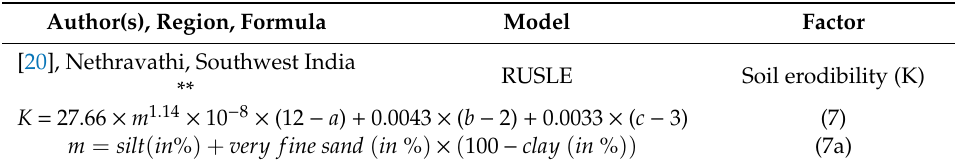
Table A2. Overview of K factor calculations of selected publications.